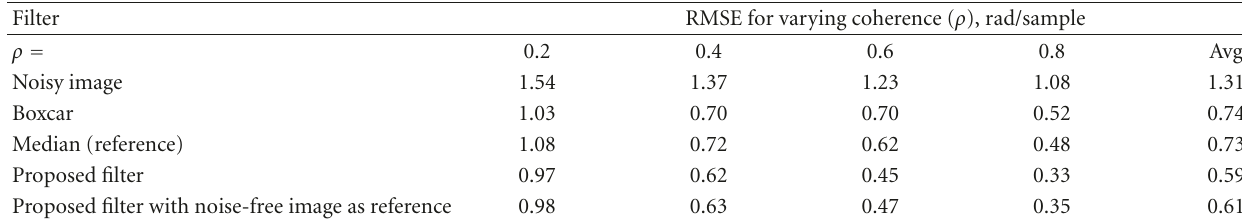
Table 1: Root mean square (RMS) error comparison for simulated images. Filter